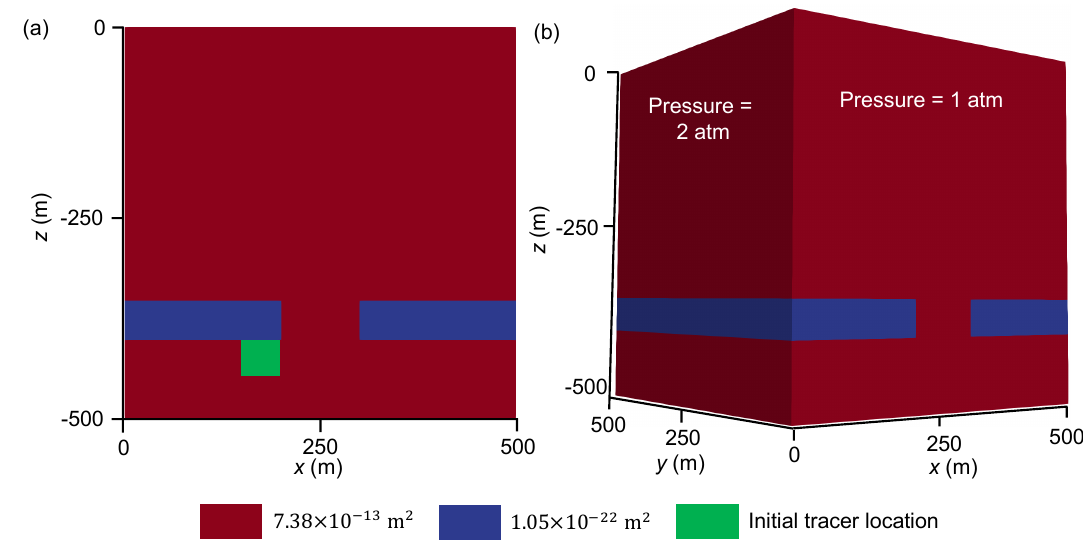
Figure 2. PFLOTRAN model domain: Schematics of ( a ) permeability distribution and ( b ) pressure boundary conditions.